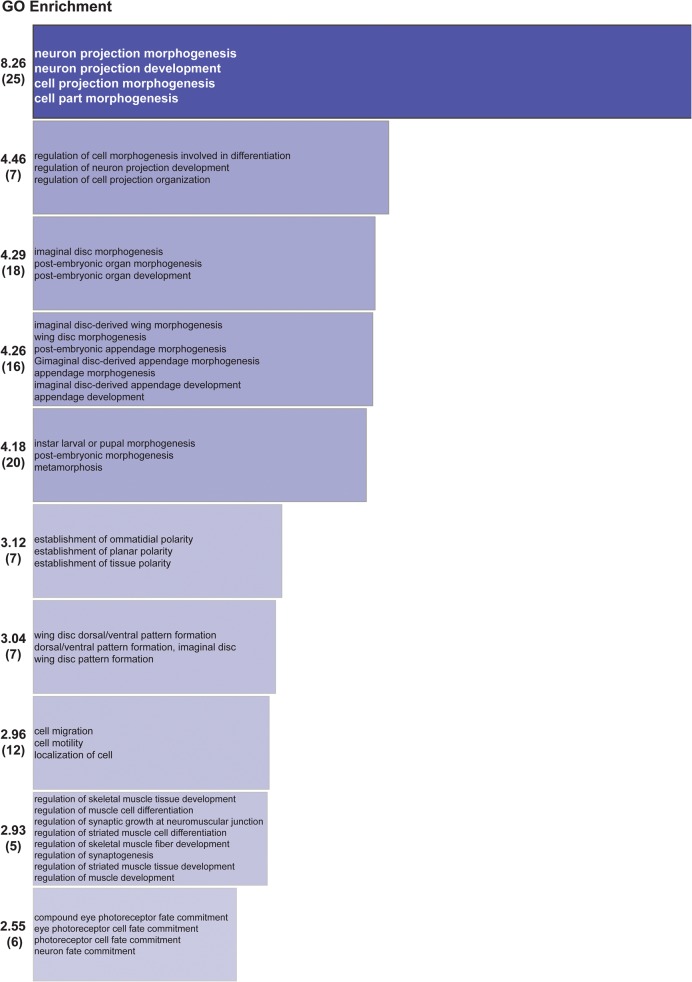
Functional annotation clustering of the Syp RIP-Seq data set. The top ten significant clusters from a DAVID GO Analysis for RNAs with a log2 enrichment >1 (see Materials and Methods). Number given is GO enrichment score (number of genes in group).